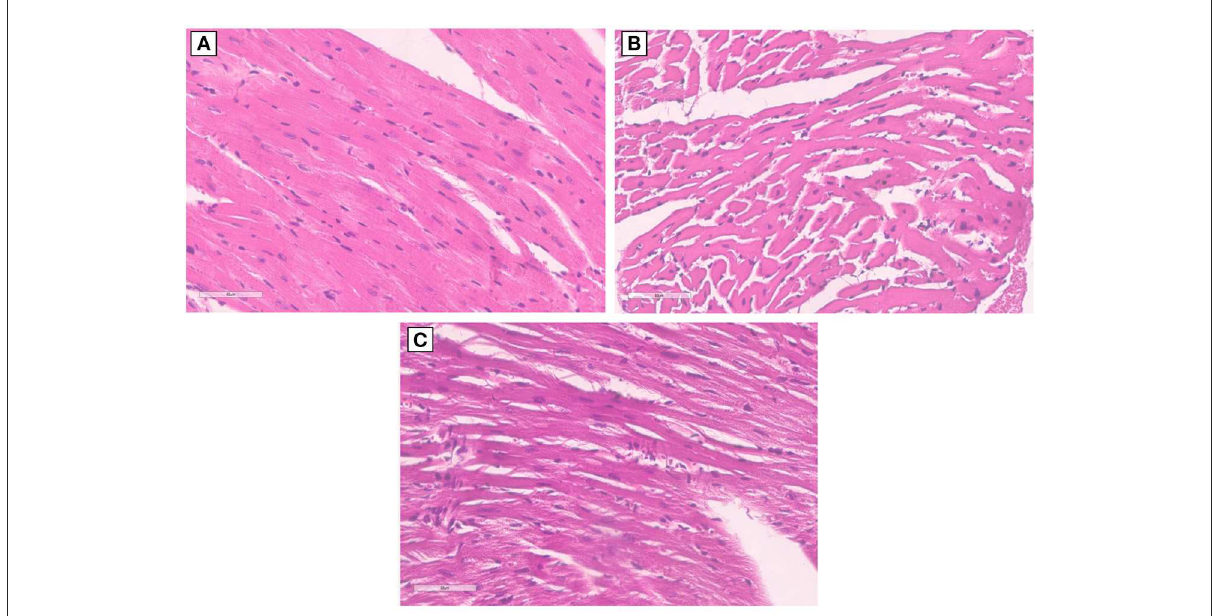
FIGURE5 Hypertrophy analysis in myocardial tissues of mice treated with ICIs. (A) Hematoxylin-eosin staining of longitudinal sections with no hypertrophy in control untreated mice (x40); (B) hematoxylin-eosin staining of longitudinal sections with no hypertrophy in untreated mice and mice treated with Ipilimumab ( × 40); (C) hematoxylin-eosin staining of longitudinal sections highlights the development of marked hypertrophy in mice treated with Pembrolizumab ( ×